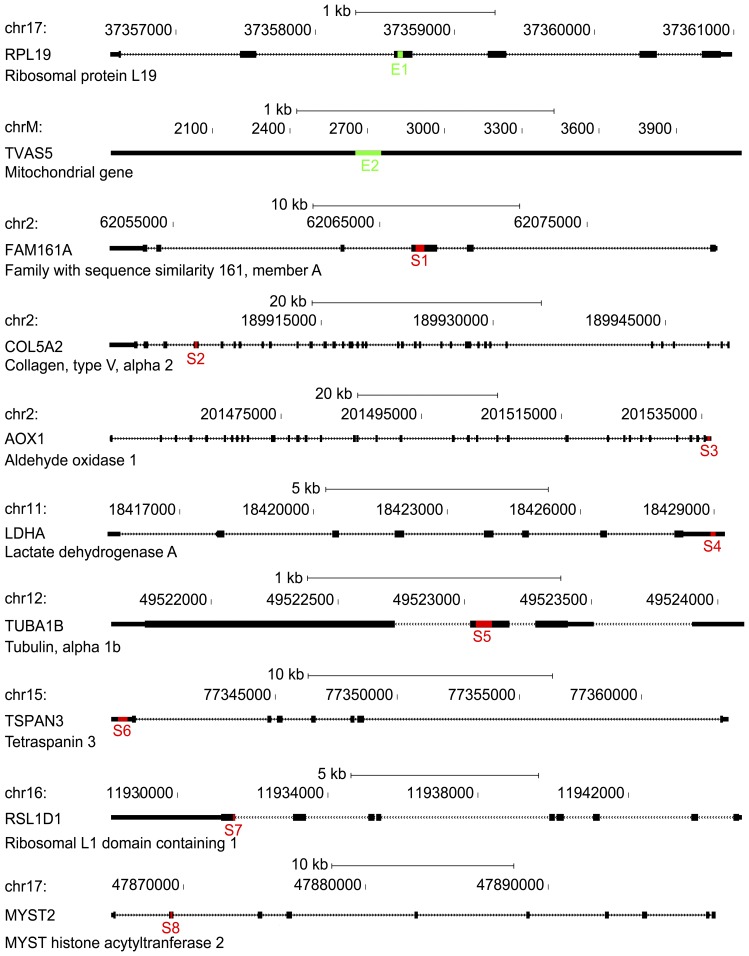
Genomic locations of exonic regulatory elements.Positions of fragments within exons, including coding regions (thick boxes) and 3′ UTRs (thin boxes).